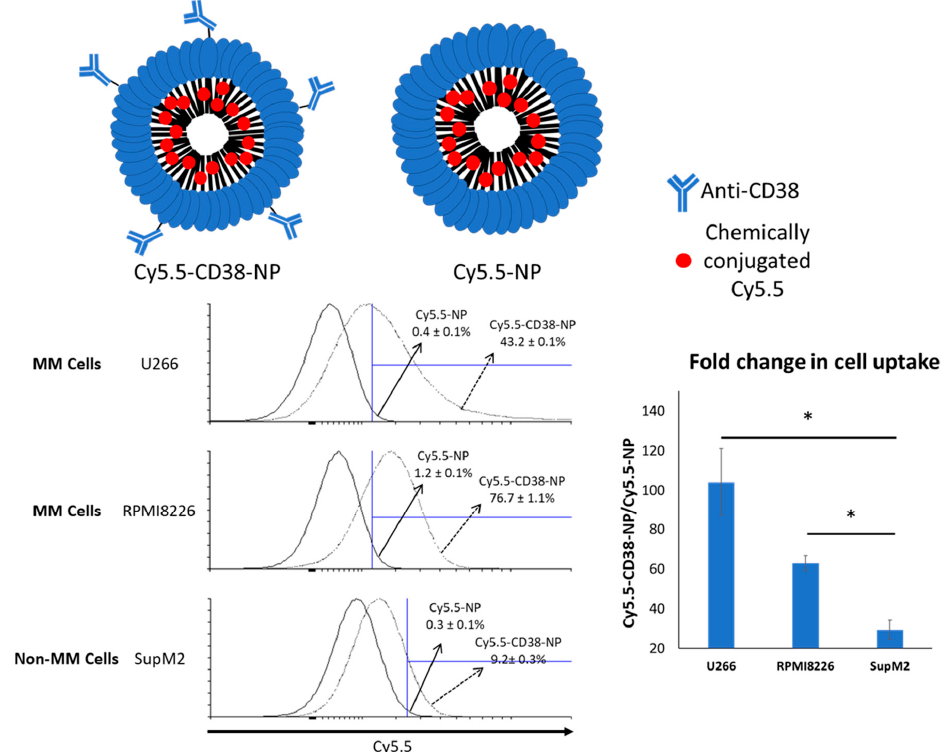
Figure 2. Flow cytometry analysis of the Cy5.5-positive cell population 4 h after treatment of Cy5.5-NP or Cy5.5-CD38-NP. Anti-CD38-conjugated NP exhibits improved cellular uptake of NP by